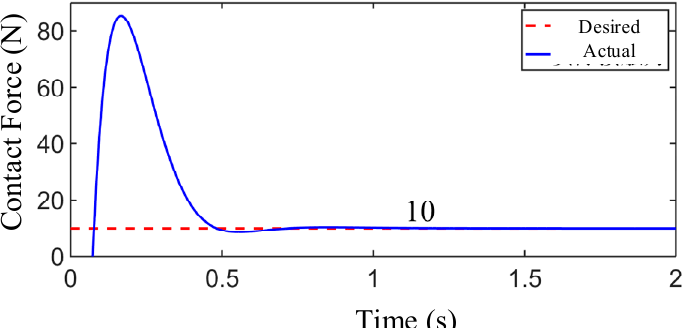
Figure 14. Force control based on online environmental parameter estimation.